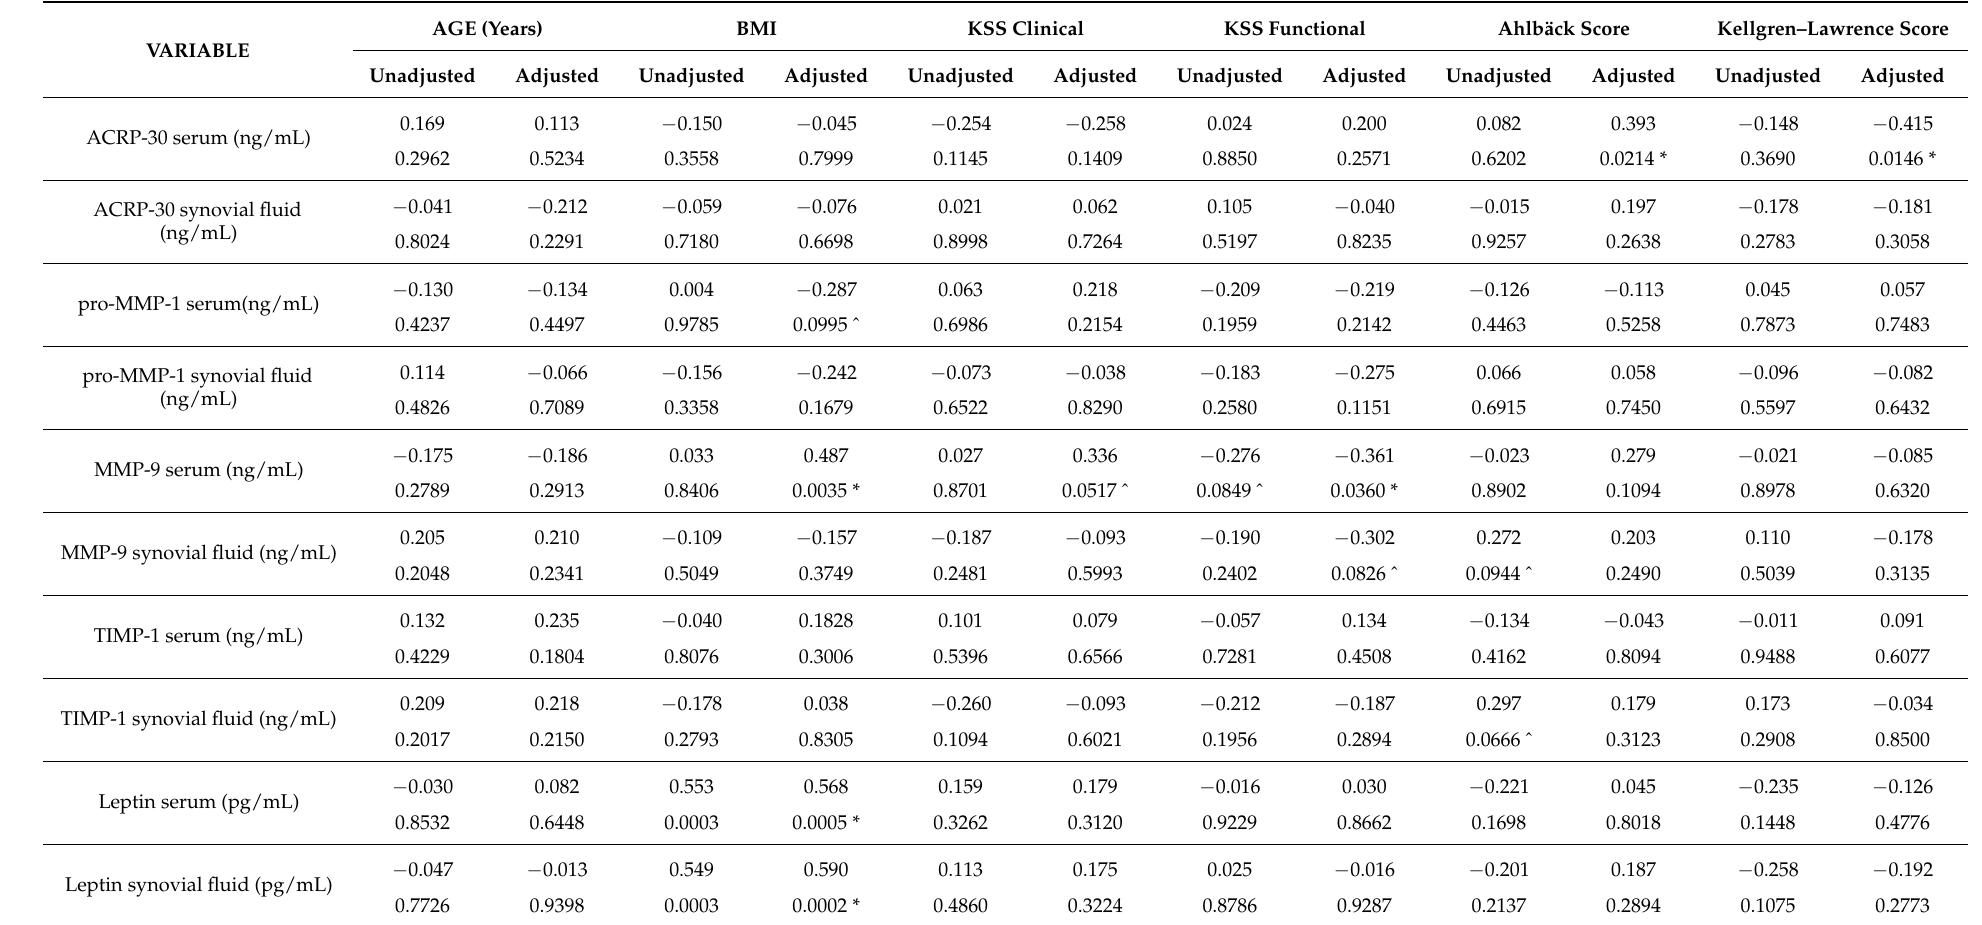
Table 3. Correlations between the levels of studied biomarkers and clinical